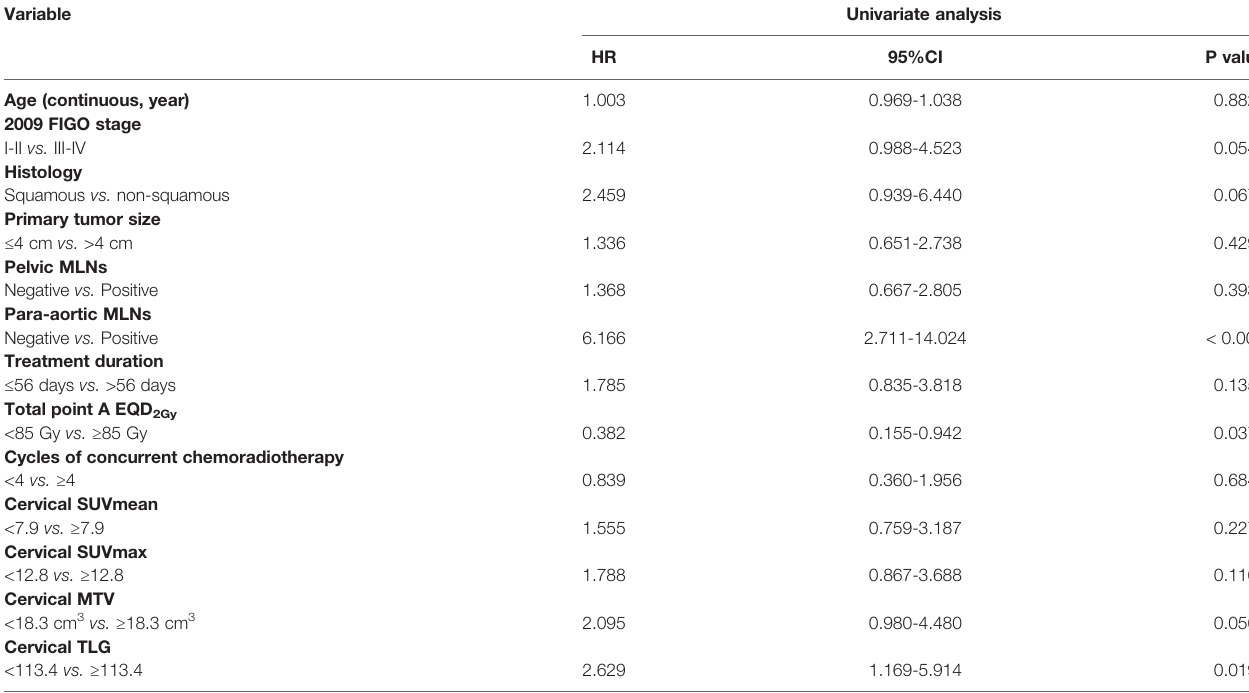
TABLE 3 | Results of the univariate analysis of clinical factors for disease-free survival.